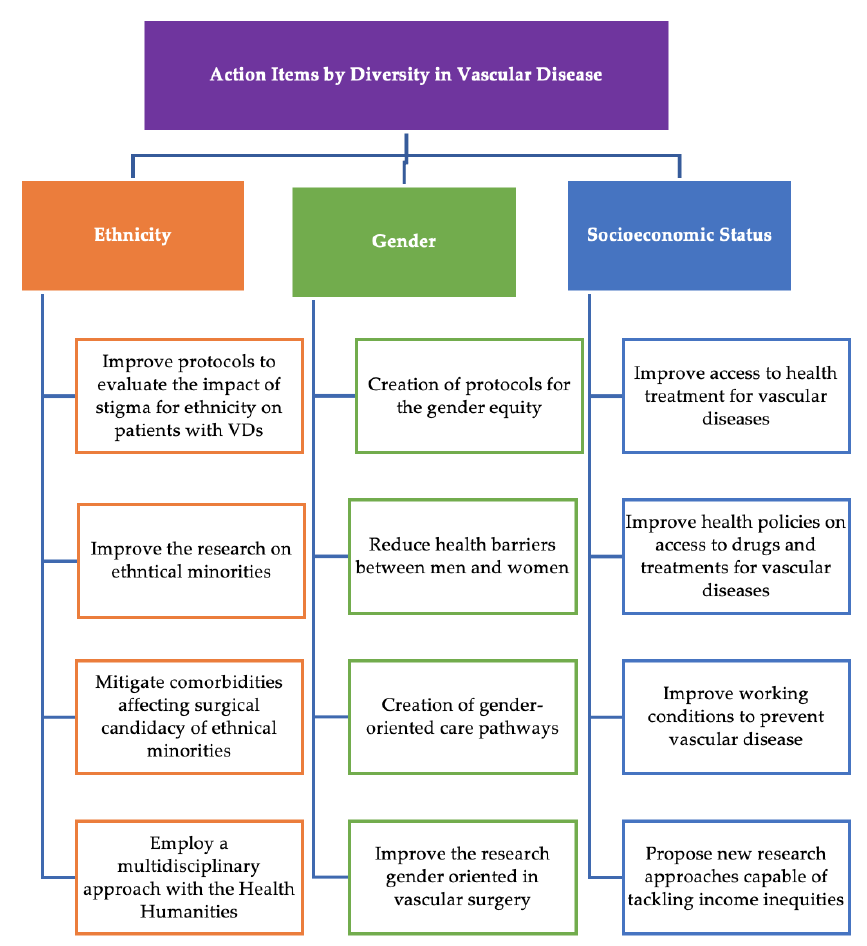
Figure 4. Action Items on SDHs in VDs.